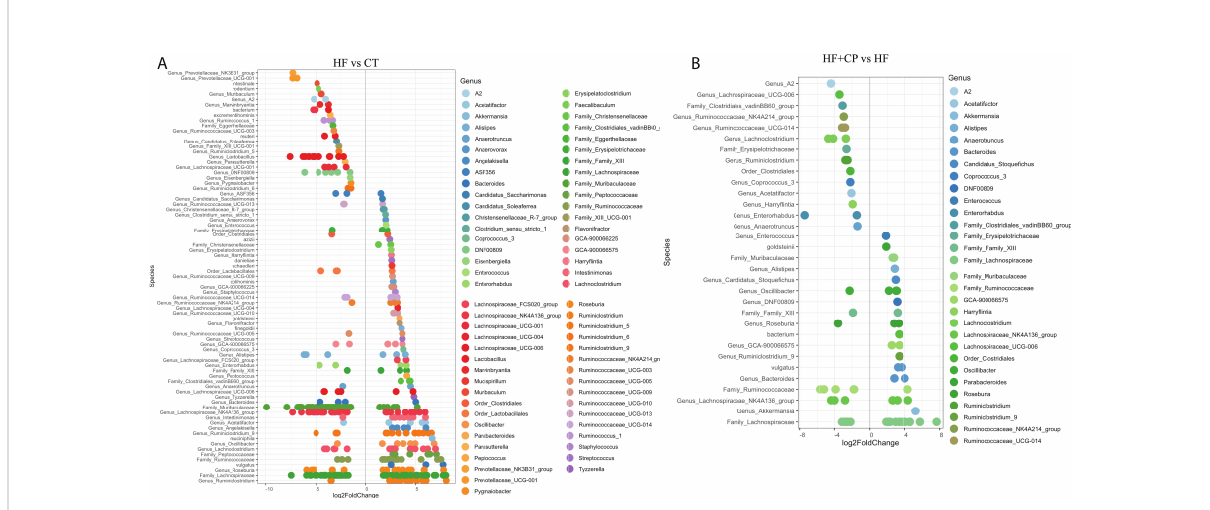
FIGURE 3 Taxa signi fi cantly upregulated and downregulated in mice fed high-fat high-sugar diet alone and in combination with cranberry polyphenols. (A) Differential abundance analysis ( DESeq2 ) revealed 79 amplicon sequence variants (ASVs) signi fi cantly modulated in mice fed high-fat high-sugar diet (HF) relative to lean mice fed chow diet (CT). (B) 32 ASVs were signi fi cantly modulated in mice fed HF + cranberry polyphenols (HF+CP) relative to HF mice. ASVs ( p < 0.05, FDR-corrected) are represented by single data points (with some data points overlapping) within each genus grouped on the x-axis, and by color fi tting to which taxonomic family the ASVs belong. Data are plotted as log2 fold change. n = 12 mice per group. ASVs to the right of the zero line are more abundant, and ASVs to the left of the zero line are less